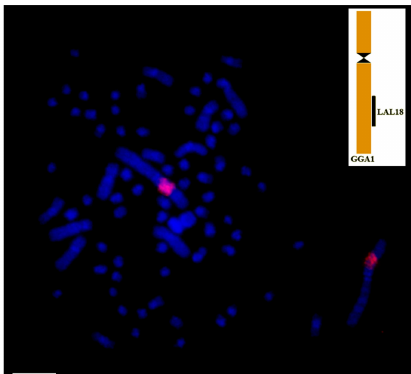
Figure 5. Result of comparative chromosome painting using corresponding to LAL18, labeled in red (CY3), on metaphases of Pulsatrix perspicillata . These probes hybridize on the same position as in G. gallus , confirming that despite the reorganization of owl’s chromosomes, they retained the ancestral organization found in PAK. Scale bar: 5 µ